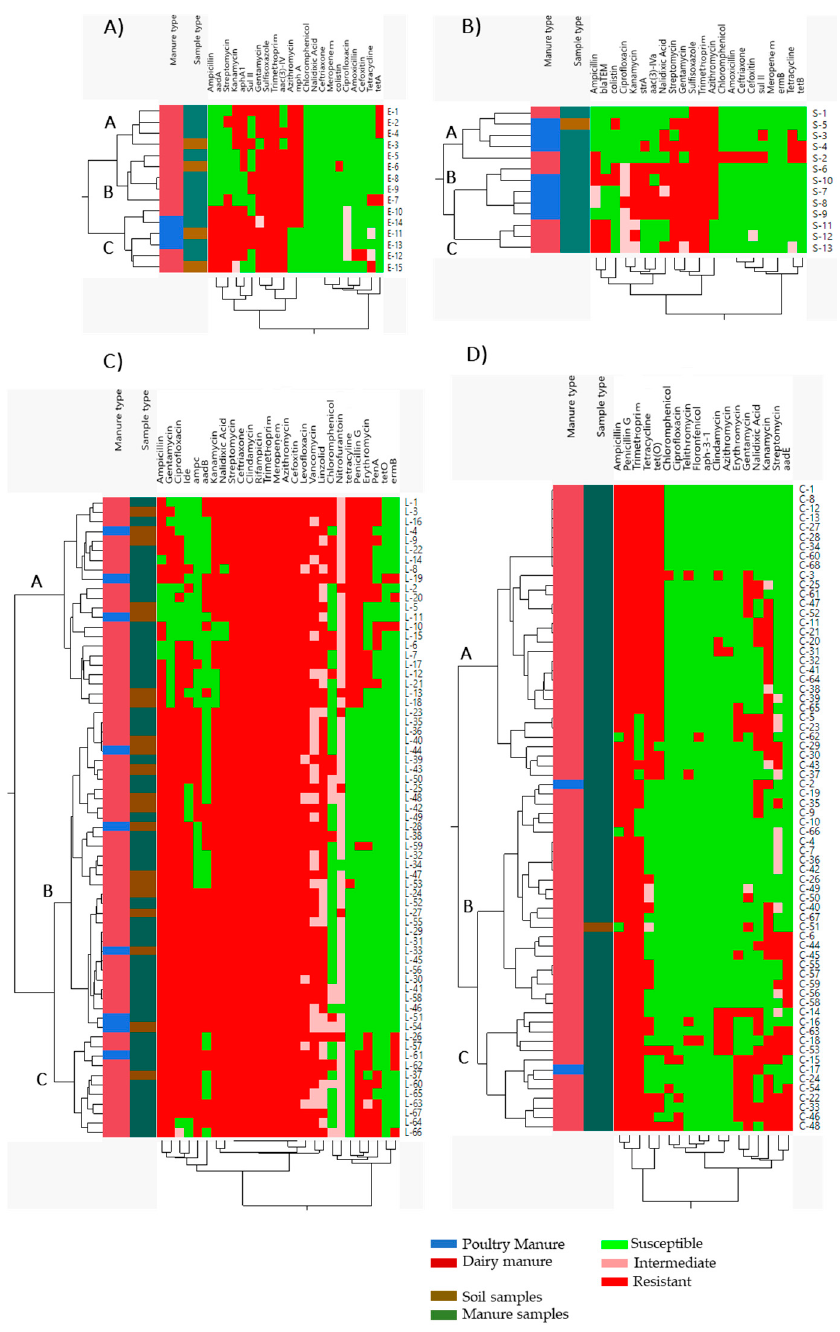
Figure 2. Hierarchical clustering of ( A ) E. coli O157, ( B ) Salmonella , ( C ) L. monocytogenes, and ( D ) Campylobacter. Sample clustered according to their manure amendment type and phenotypic and genotypic antibiotic resistance profile. Red color, phenotypic resistance and presence of ARGs; green color, susceptible and absence of ARGs; blue color, poultry manure amendment; dark red color, dairy manure amendment; dark green color, manure samples; and brown color, soil